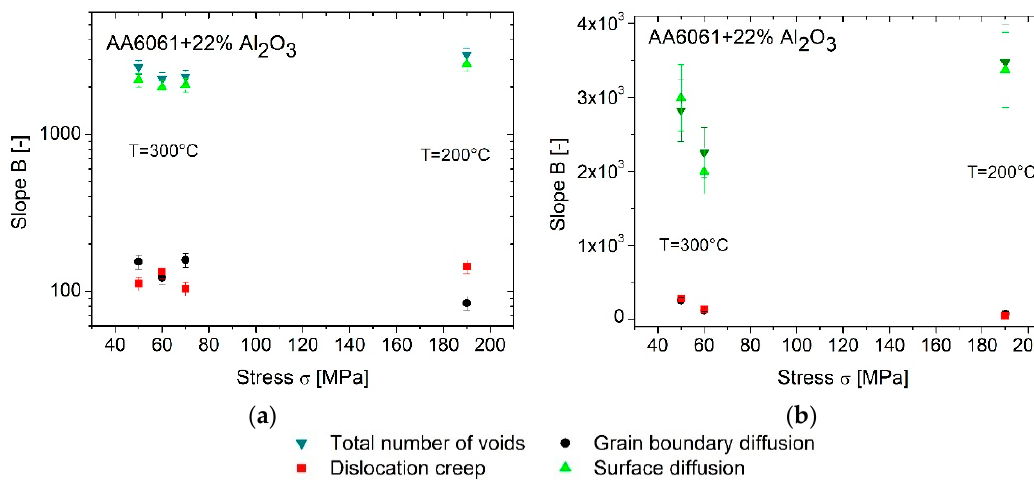
Figure 9. Al-MMC, void formation, linear fit parameter 𝐵 : ( a ) early stage; ( b ) late stage.